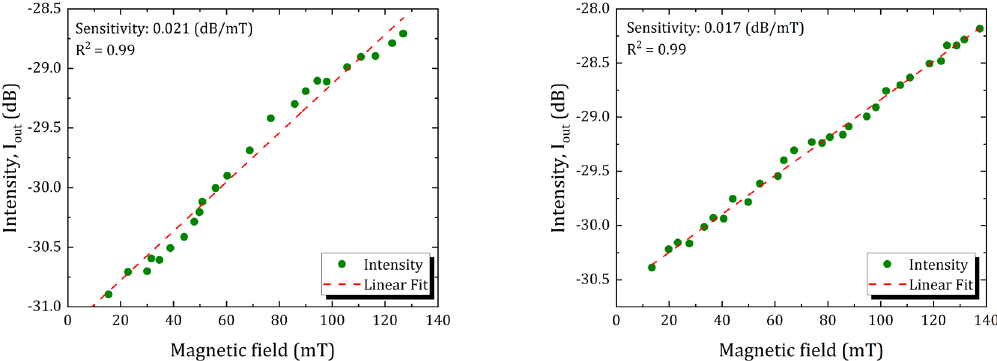
Figure 4. Measurements of the output intensity as a function of magnetic field variation for ( a ) L = 30mm , and ( b ) L = 40mm .